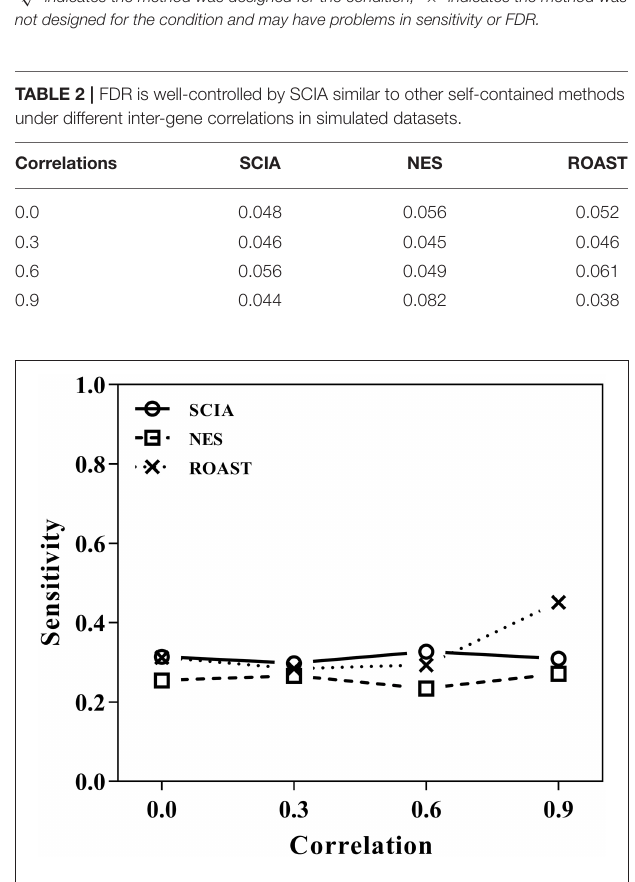
TABLE 1 | Application scope of the different methods evaluated in this study. Conditions SCIA Self-contained Competitive High intergene correlations High prop. of background